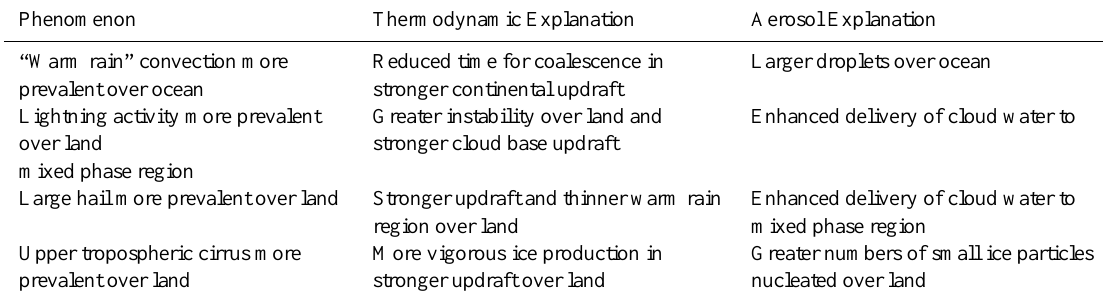
Reduced time for coalescence in stronger continental updraft Greater instability over land and stronger cloud base updraft region over land More vigorous ice production in stronger updraft over land